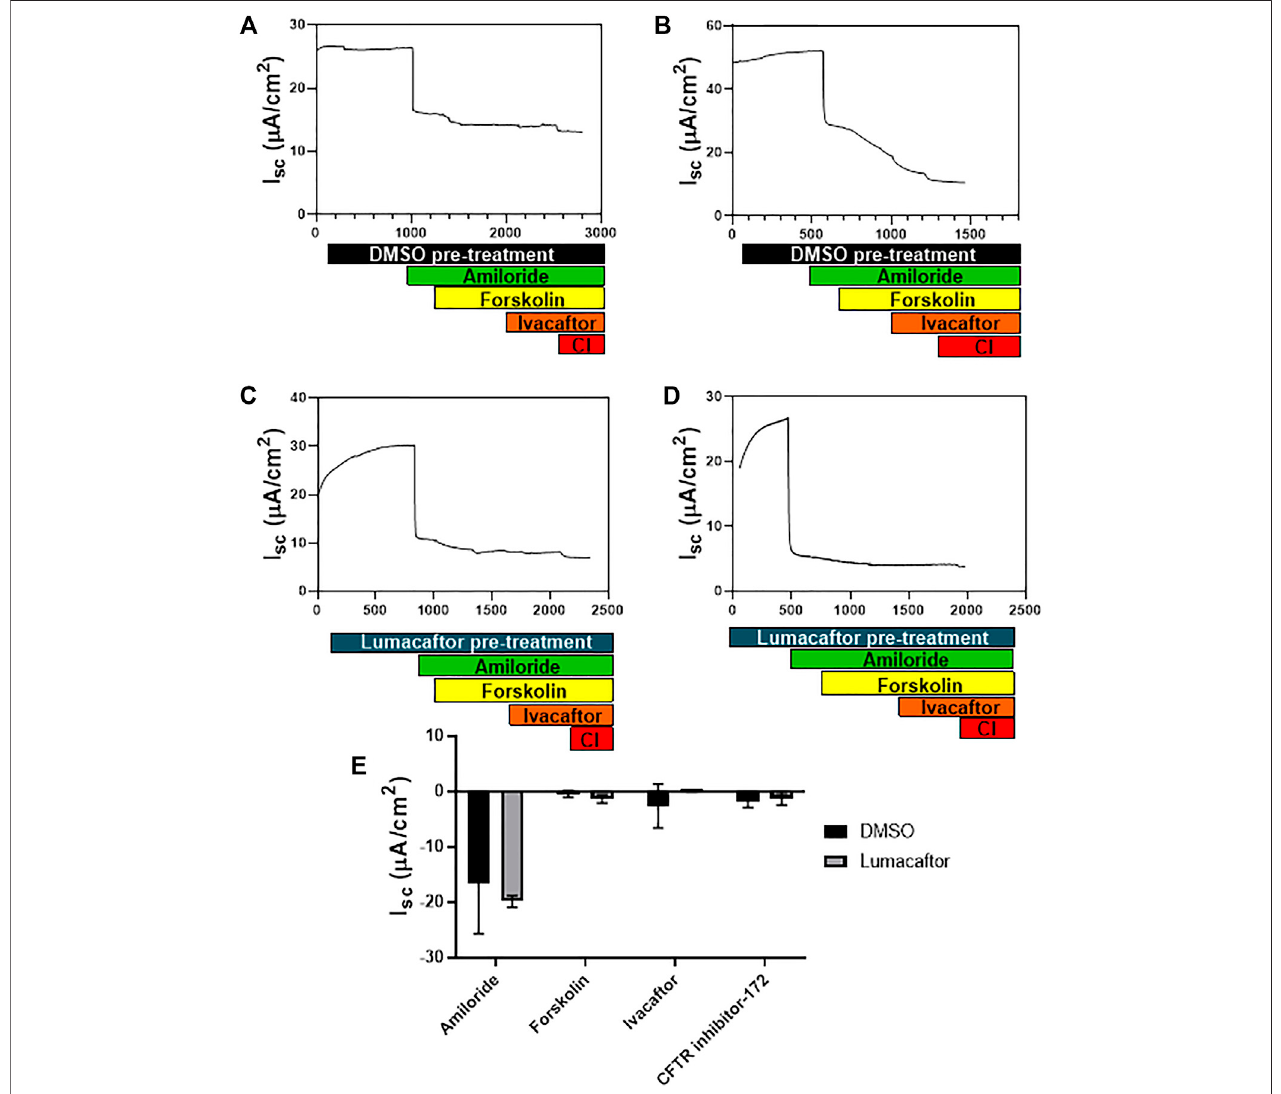
FIGURE 4 | Cftr Δ 9/ Δ 9 epithelial cell CFTR function. (A,B) . Ussing chamber tracing showing change in short circuit current ( Isc ) in response to drug stimulation on Cftr Δ 9/ Δ 9 ALI cultures pre-treated for 24 h with DMSO. (C,D) . Ussing chamber tracing showing change in Isc in responseto drug stimulation on homozygote Cftr exon 9 deleted ALI cultures pre-treated for 24 h with Lumacaftor. (E) . Summary of changes in Isc in response to amiloride, forskolin and CFTR inhibitor-172 for Cftr Δ 9/ Δ 9 ALI cultures pre-treated with DMSO (Black bars) or Lumacaftor (Grey bars) ( Isc , n = 2).Pre-treatment with DMSO (black bar) pre-treatment with Lumacaftor (blue bar), Amiloride addition (green bar), Forskolin stimulation (yellow bar), Ivacaftor stimulation (orange bar), CFTR inhibitor-172 (CI-red